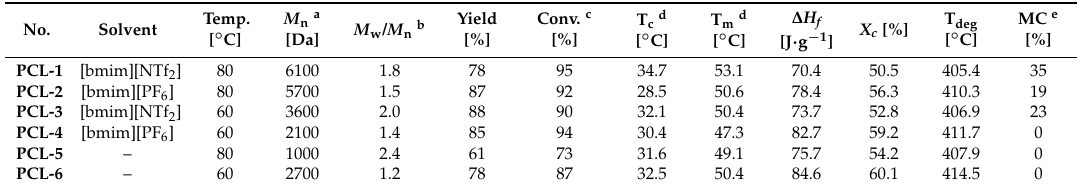
Table 1. Characterization of poly( ε -caprolactone) (PCL) matrices synthesized in the presence of Candida antarctica (CALB) in ionic liquids